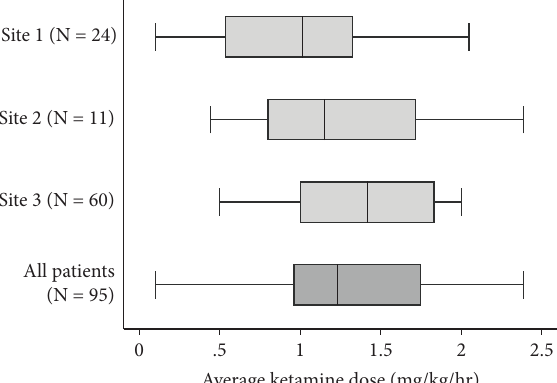
Figure 1: Ketamine Dose. Te distribution of average ketamine dose (mg/kg/hr) in the frst 24 hours of use by study site and for all patients. Te vertical line (within the shaded boxes) represents the median value, the shaded boxes represent the interquartile range, and the whiskers represent adjacent values.